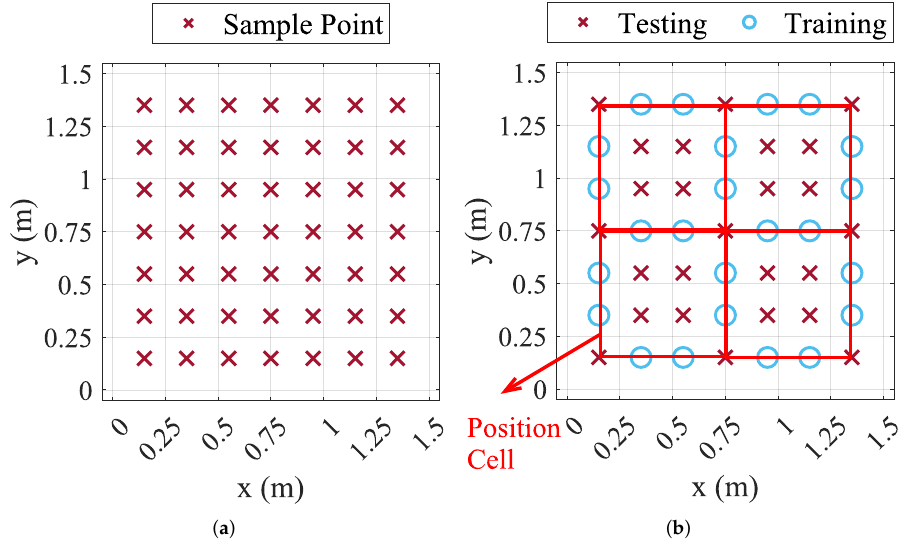
Figure 4. The sample points of each surface. ( a ) The original, and ( b ) the division of ML